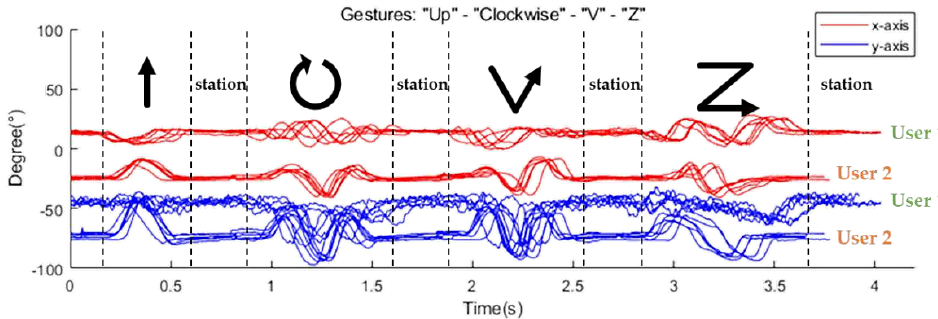
Figure 2. Example outputs of the flex sensor (four types of gestures from two users).